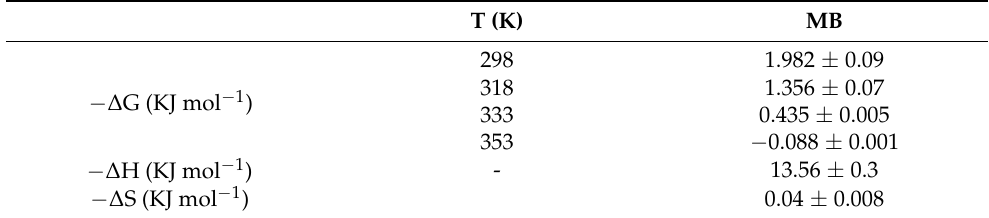
Table 6. Thermodynamic parameters for MB dye removal from aqueous media by P@SiO 2 nanocomposite. T